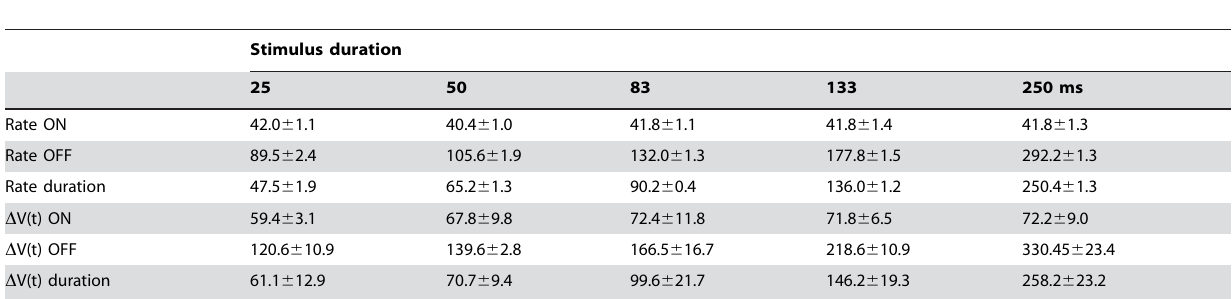
Table 1. Peak latencies and peak to peak time intervals for multiunit firing rates and population membrane potentials (mean 6 stand. deviation).